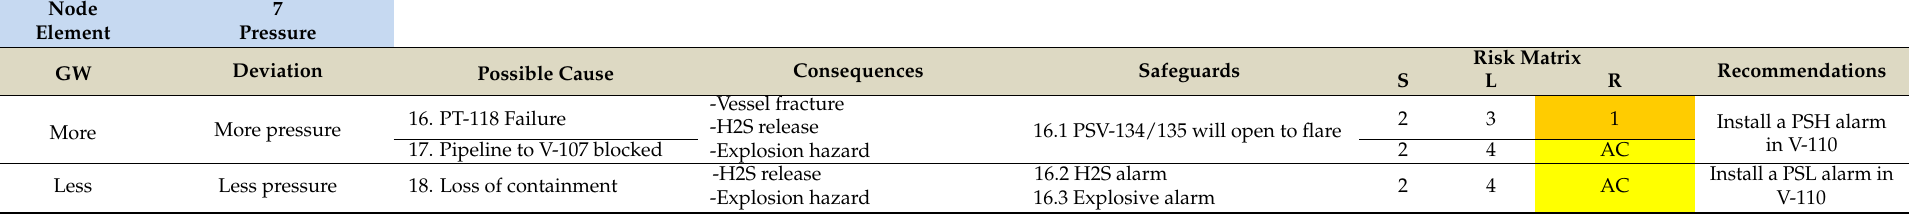
Table 7. HAZOP study results for the deviations specified in the SCOPI’s Node #7 concerning the element “Pressure”, in association with (i) risk-matrix outcomes and the SC coding, and (ii) the depiction of appropriate guidewords, possible causes, consequences, safeguards and recommendations. Node